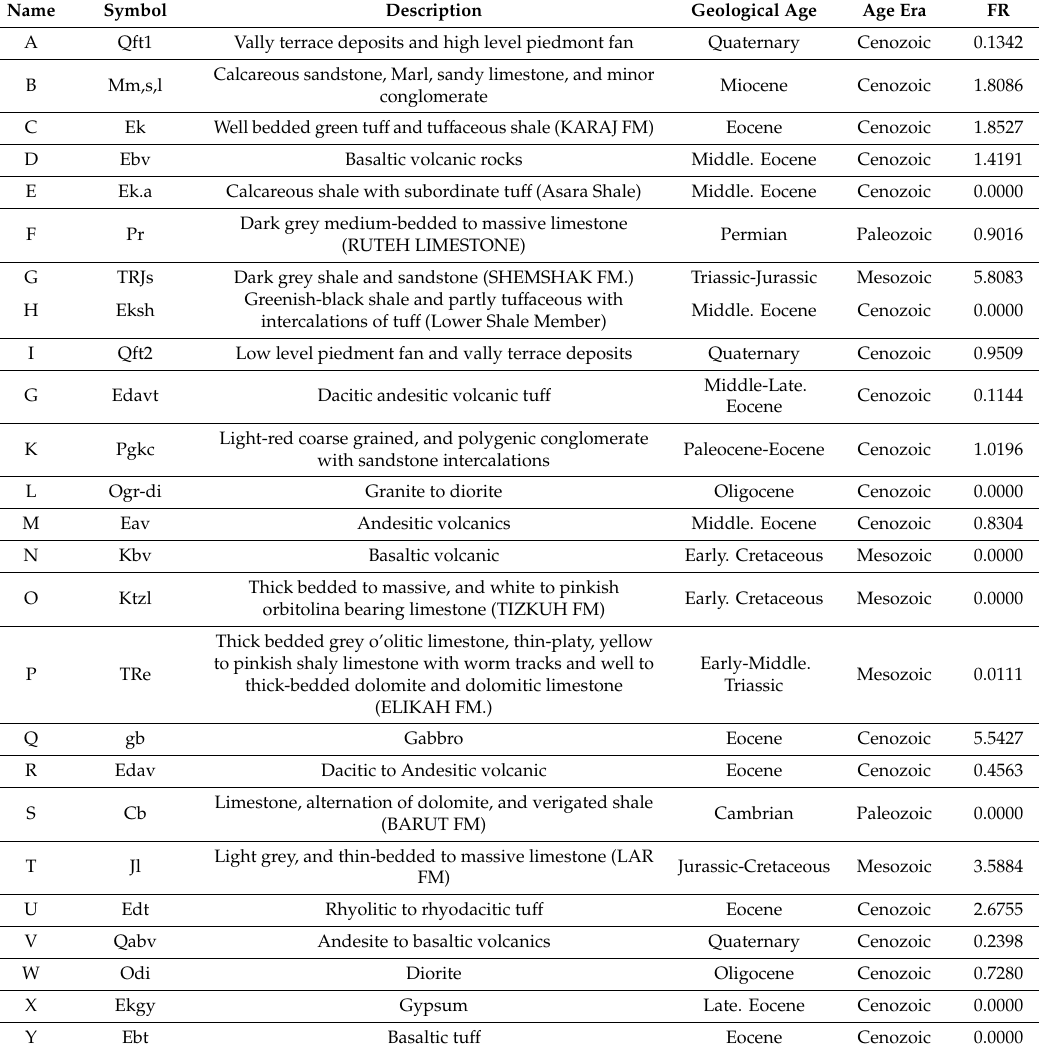
Figure 3. The obtained FRs for landslide conditioning factors: ( a ) elevation, ( b ) slope aspect, ( c ) climate, ( d ) plan curvature, ( e ) soil type, ( f ) distance to river, ( g ) distance to road, ( h ) distance to fault, ( i ) land cover, ( j ) slope degree, ( k ) SPI, and ( l ) TWI. A digital elevation model (DEM) of the Qazvin County with 10 m spatial resolution was created Table 1. The description of the lithology